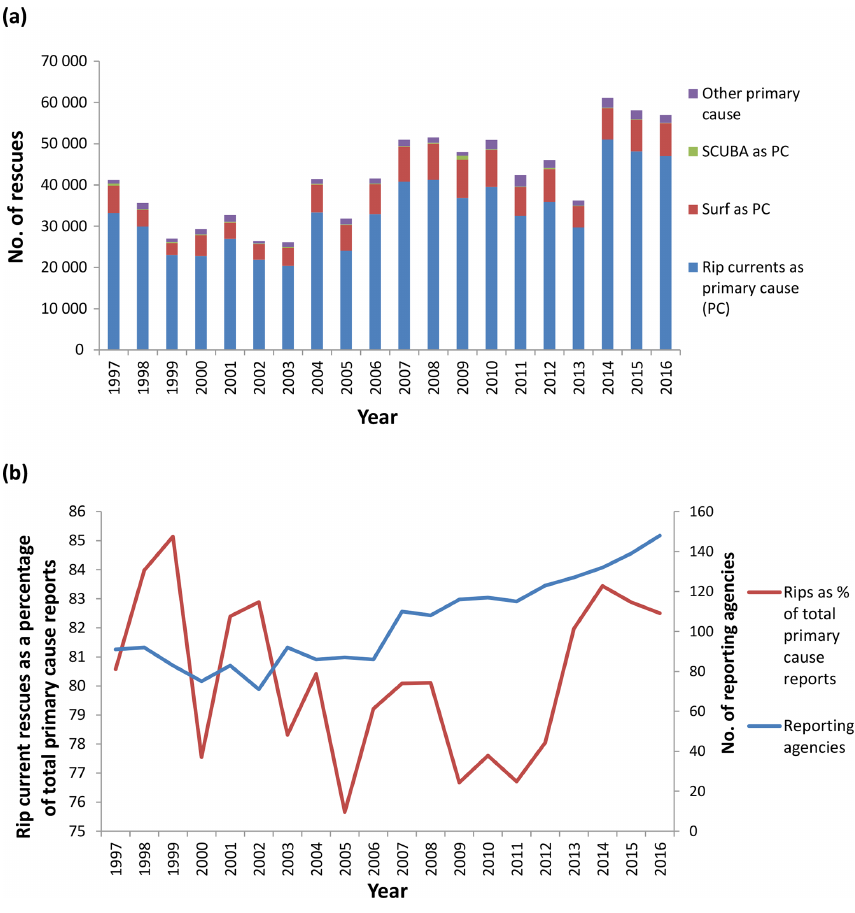
Figure 2. (a) Total rescues reported to the USLA by primary cause over the period 1997–2016. (b) Percentage of rip current rescues as primary cause and the number of lifeguard reporting agencies to the USLA over the period